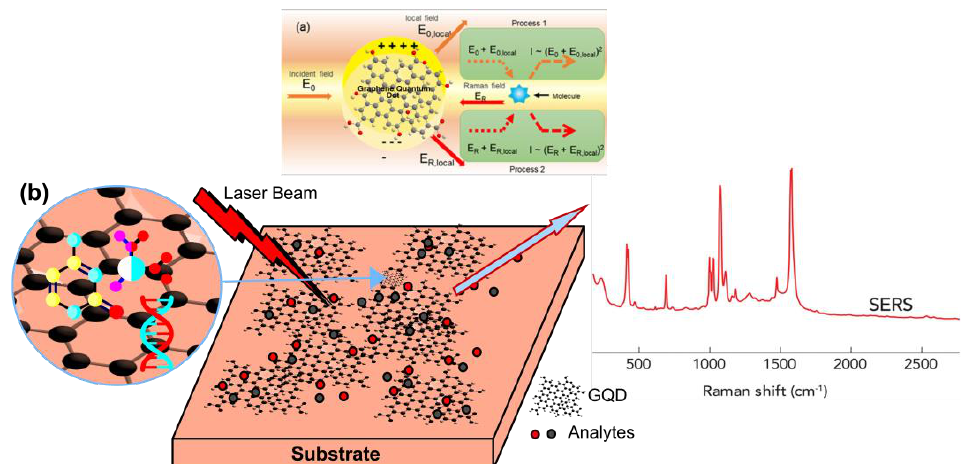
Figure 4. ( a ) Mechanism of the surface-enhanced Raman scattering (SERS) electromagnetic (EM) effect, electromagnetic SERS enhancement. Reprinted with permission from [114]. Copyright © 2020, American Chemical Society. ( b ) Schematic illustration of molecules on graphene and a substrate and Raman experiments. Reprinted with permission from [112], Copyright © 2010, American Chemical Society.